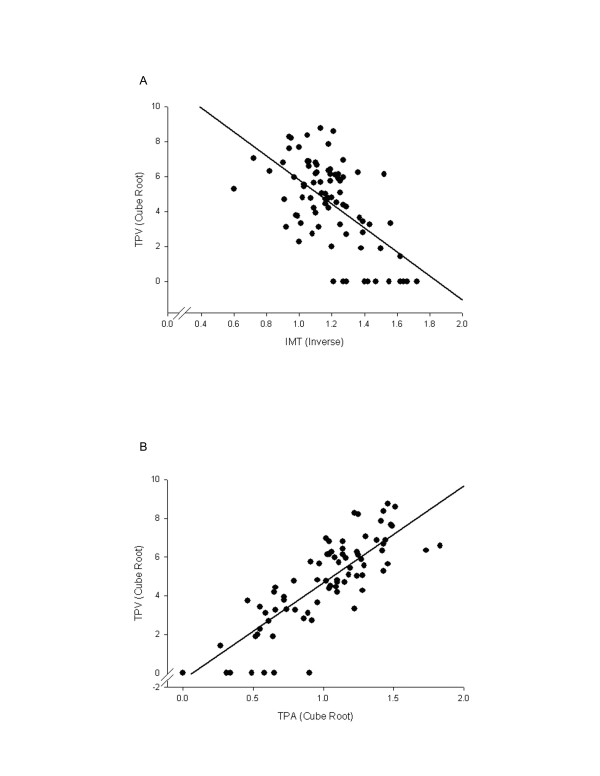
Ultrasound phenotype correlations for diabetic nephropathy population. A) Pearson Correlation for IMT and TPV in diabetic subgroup and B) Pearson Correlation for TPA and TPV in diabetic subgroup.